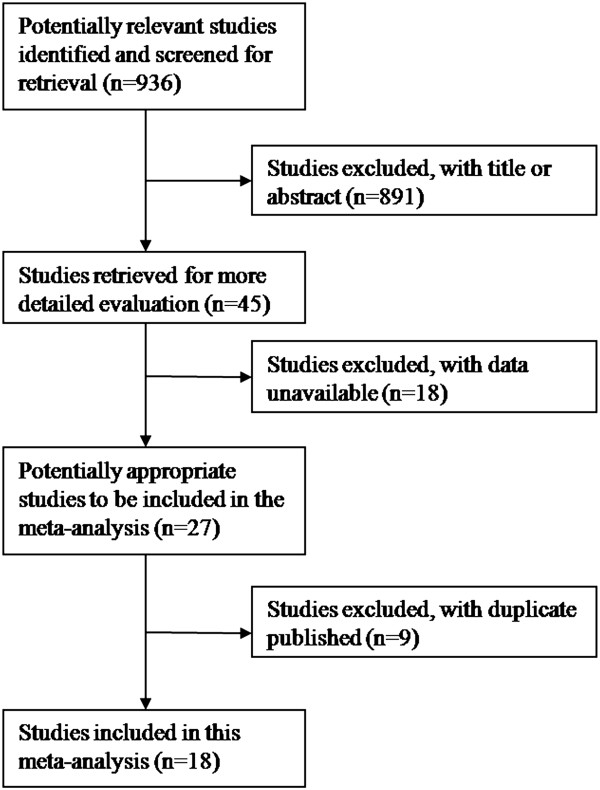
The flow diagram of literature screening process.